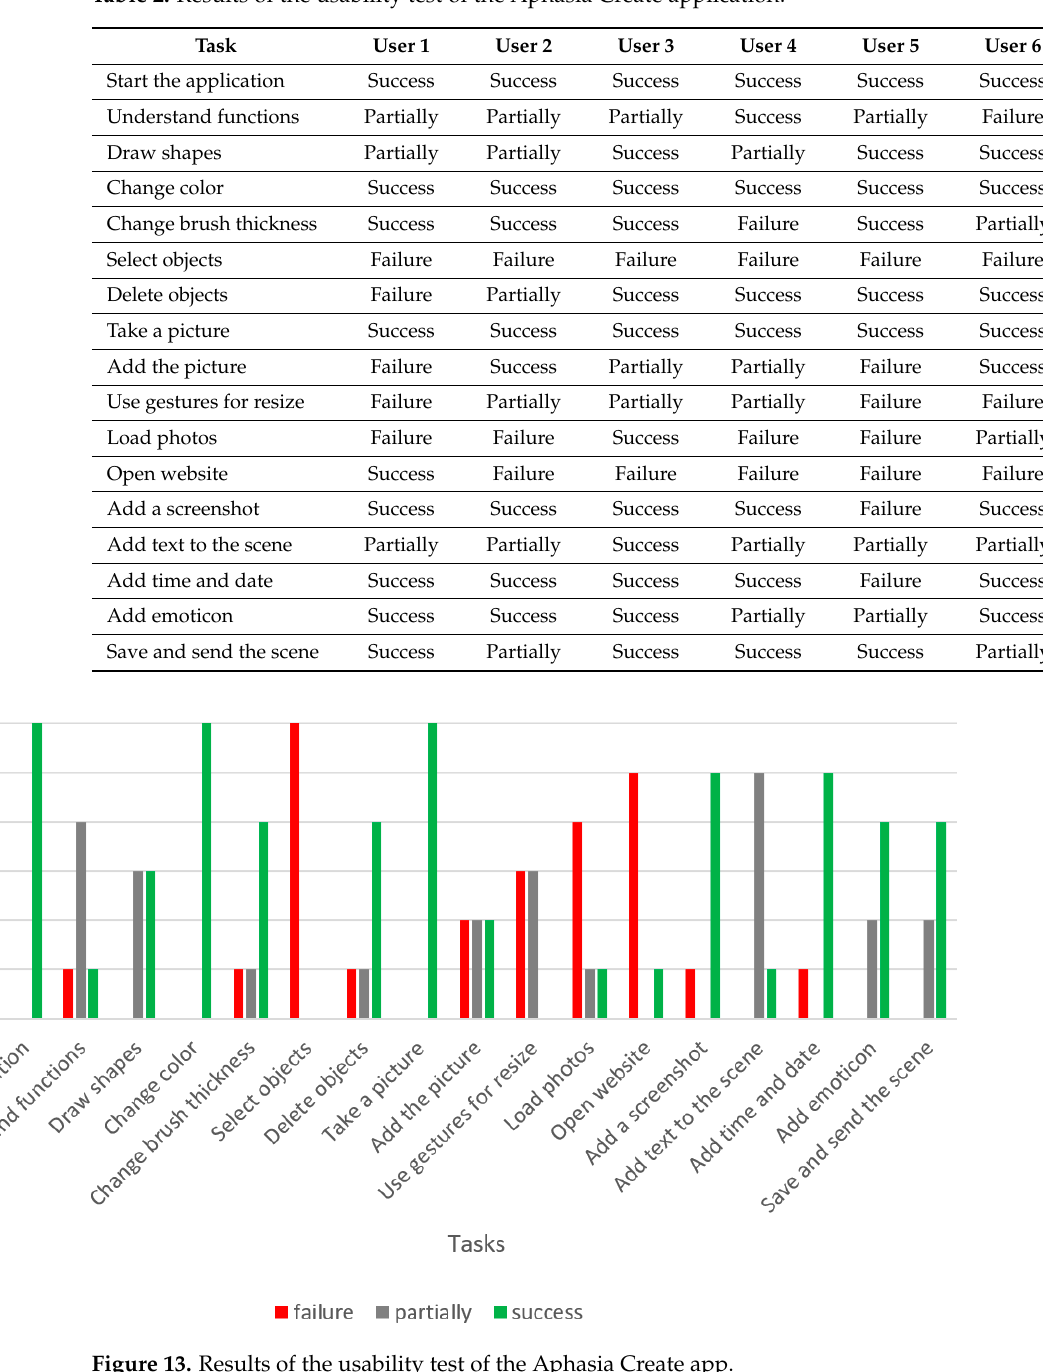
Figure 13. Results of the usability test of the Aphasia Create app.